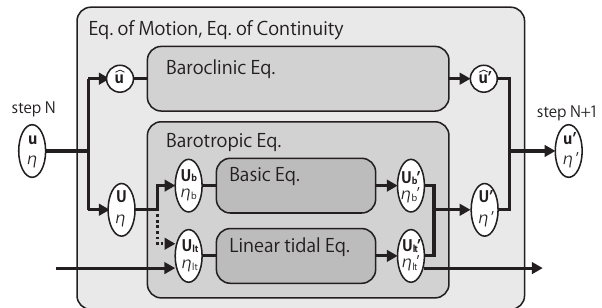
Fig. 1. A schematic view of the calculation procedure of the tide scheme. From u and (cid:17) at the time step N , u ′ and (cid:17) ′ at the next step N +1 are calculated following the equations of motion and continuity. In the calculation process, the mode splitting technique splits the variables into the baroclinic constituent, ˆ u , and the barotropic one, U and (cid:17) , and then the tide scheme splits the latter into the basic compo- nent, U b and (cid:17) b , and the linear tidal component, U lt and (cid:17) lt . Each component calculates time evolution ( ˆ u ′ ; U ′ b ;(cid:17) ′ b ; U ′ lt and (cid:17) ′ lt ), and subsequently all of them are summed to obtain u ′ and (cid:17) ′ . The dashed and solid arrows which point to U lt and (cid:17) lt mean that their time evolution are given almost independently (see the main text).